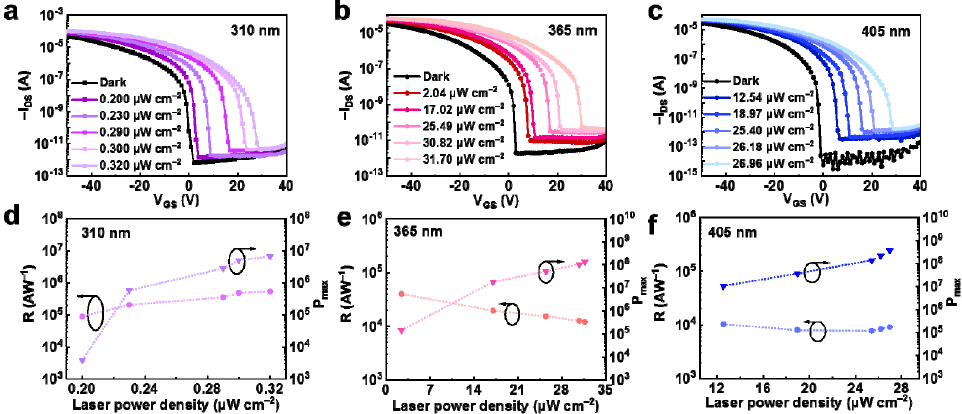
Figure 6. Transfer characteristics of organic phototransistors (OPTs) measured under different illumination intensities at wavelengths of ( a ) 310 nm, ( b ) 365 nm and ( c ) 405 nm. Responsivity ( R ) and photosensitivity ( P ) of OPTs as a function of the laser power density at wavelengths of ( d ) 310 nm, ( e ) 365 nm and ( f ) 405 nm. The channel length was 100 μ m and the channel width was 100 μ m.